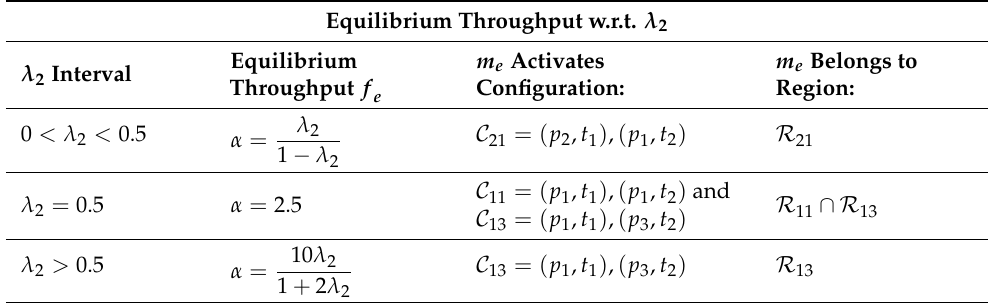
Table 3. Equilibrium throughput w.r.t. λ 2 and its characteristics of the MTS net depicted in Figure 8a. Equilibrium Throughput w.r.t. λ